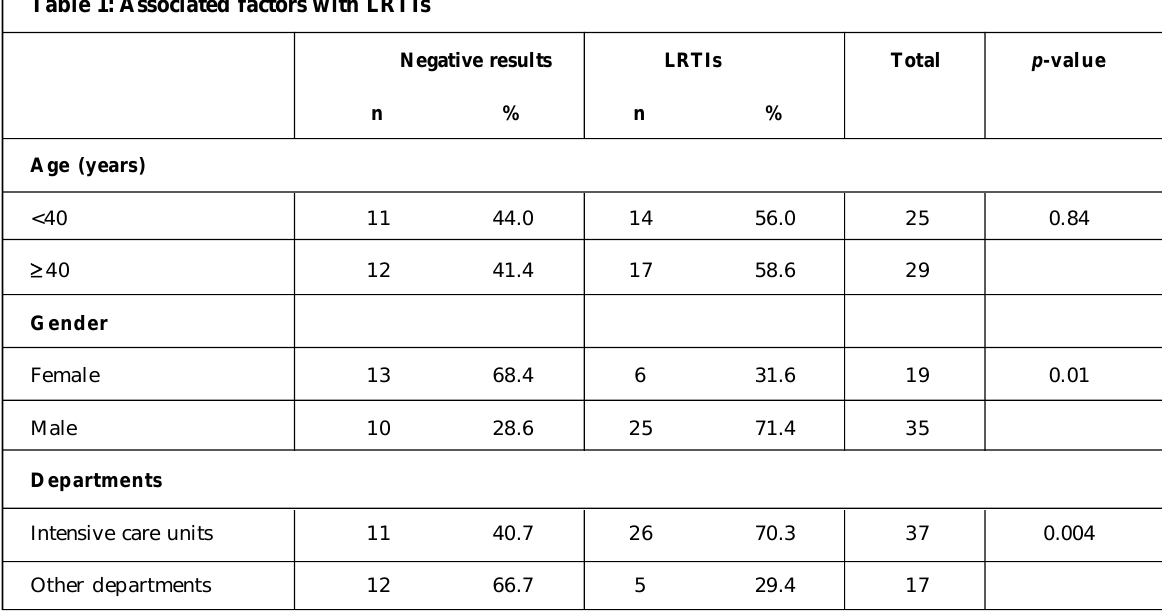
Table 1: Associated factors with LRTIs Negative results LRTIs Total p